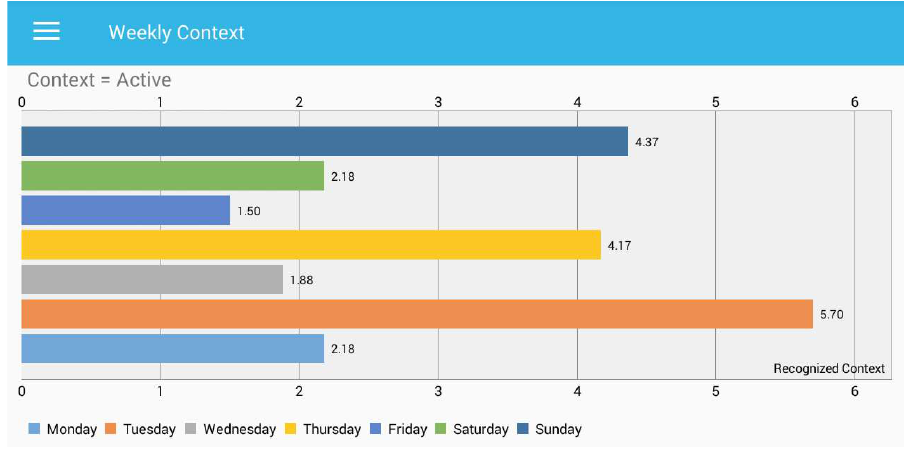
Figure 10. Total time spent during a week while being “active”.